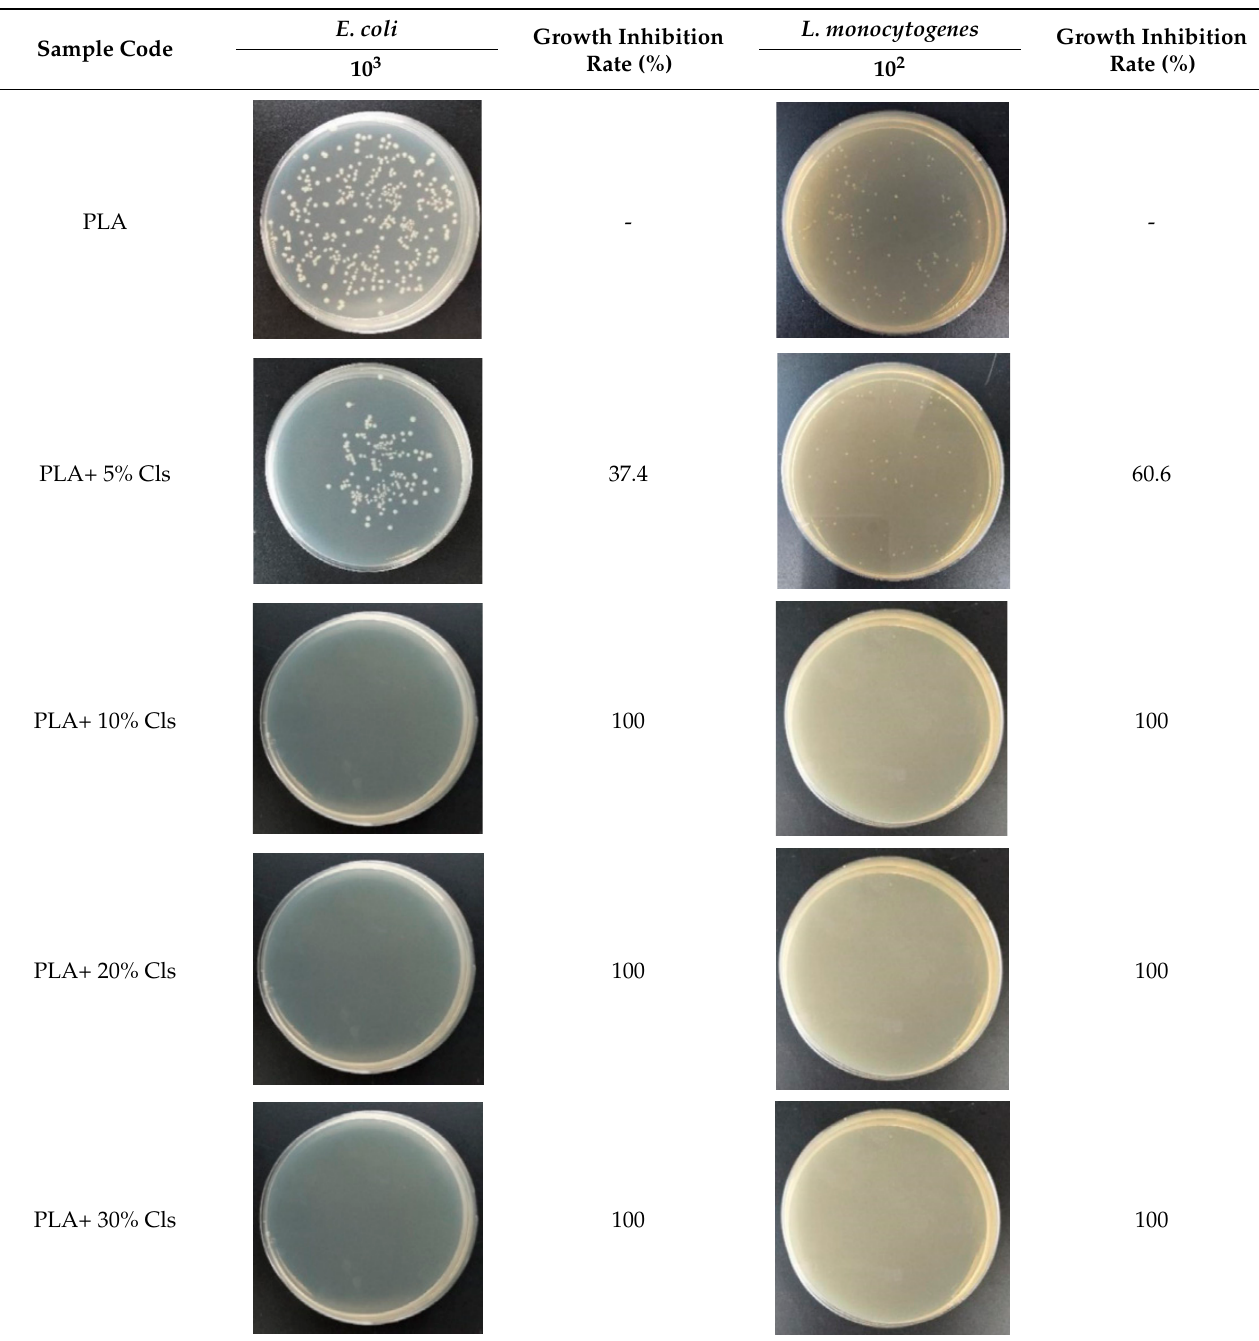
Figure 3. Release curves of antibacterial PLA antibacterial films with 5, 10, 20, and 30% of Cis. Re- printed with permission from Ref. [66] , published by Elsevier, 2022. Cui et al. [69] used carbon nanotubes (CNTs) to load cinnamaldehyde (CIN), mixed them with polylactic acid, evaporated them to make films, and finally made PLA, PLA/CNTs, PLA/CIN, and PLA/CNTs/CIN films. The results showed that the plasticizing effect of cinnamaldehyde improved the flexibility of the composite film and the layered structure of the carbon nanotubes better resisted ultraviolet radiation and controlled the release rate of cinnamaldehyde. The controlled release of cinnamaldehyde was mainly divided into two steps: first, cinnamaldehyde is released from the composite membrane to the outside of the membrane, and then further released to the surrounding environ- ment. From the experimental data, the release of CIN was controlled by carbon nanotubes and polylactic acid double carriers so its bacteriostatic time was prolonged. On the 14th day of the experiment, it was found that there was no significant difference in the bacterial count between the PLA/CIN composite film and the PLA film. On the 21st day, it was found that the bacterial count of the PLA/CNTs/CIN composite film was the same as that